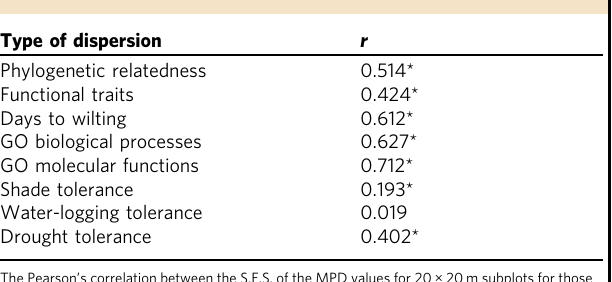
Table 3 The relationship between community dispersion and soil water content in the forest dynamics plot using point